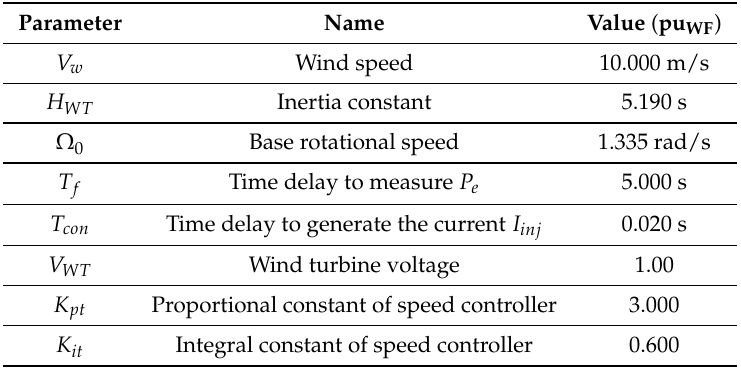
Table A4. Wind power plant parameters